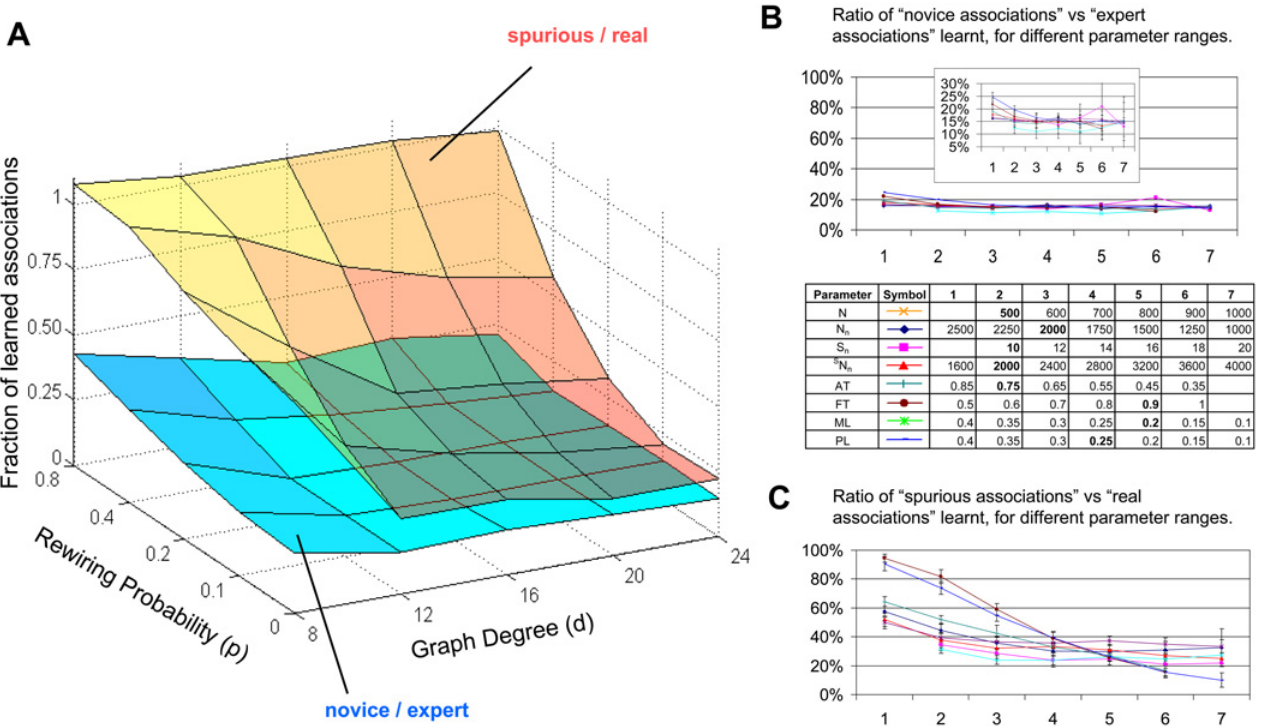
Fig 4. Generalization of ADO to biologically realistic mechanisms. A . BIG learning with cell-assemblies in small-world graphs of different connectivity: Ratios between the percentages of associations learned in the novice vs. expert domain (bottom surface) and for spurious vs. real co-occurrences (top surface) with varying graph degrees and rewiring probabilities when using cell assembly representation of Watts-Strogatz graphs. Lower rewiring probabilities and, to some extent, higher degrees improve the ability to discriminate real from spurious co-occurrences. These conditions correspond to highly clustered (as opposed to fully random) graphs. The ability to learn new associations within the domain of expertise remains more than double compared to a novice domain. B . Robustness of the BIG ADO mechanism: Ratios between the percentages of associations learned in the novice vs. expert domain with cell assembly representation of Watts-Strogatz graphs when varying (typically one at a time) several model parameters. The full ordinate scale is used to allow comparison with panel C, but the same data are also expanded in the inset to emphasize the invariance of the results (error bars: standard deviation). All parameter values are reported in the table legend below the plot (with default values in bold). The parameters and their abbreviations are: the number of nodes in the Watts-Strogatz graph (N), which also implies a change in the graph degree, d (kept at 2% of N) as well as the number of pre-training associations (corresponding to N×d/4, that is one half of the pool of available associations); the number of neurons in the network (N n ) and the cell assembly size (S), whereas N was also varied together with S ( S N n ) so as to keep their ratio constant at 200; the activation threshold (AT), i.e. the fraction of neurons in the cell assembly that need to be synchronously active in order to “ identify ” the node of the graph represented by that assembly; the firing threshold (FT), i.e. the proportion of presynaptic neuron required to fire in order to activate a postsynaptic neuron; the matrix load (ML), i.e. the constant fraction of presynaptic neurons connected to each postsynaptic neuron in the cell assembly learning model; and the proximity load (PL), i.e. the (top) fraction of axonal-dendritic overlaps throughout the network that are considered to be potential synapses (see also S1 Text 2.4). C . Optimal conditions for one-trial learning of real but not spurious associations: Ratios between the percentages of associations learned for spurious vs. real co-occurrences with cell assembly representation of Watts-Strogatz graphs when varying the same model parameters as in Fig. 4B. The most tunable parameters are the firing threshold (neuronal excitability) and the proximity load (strength of BIG ADO filter: see S1 Text